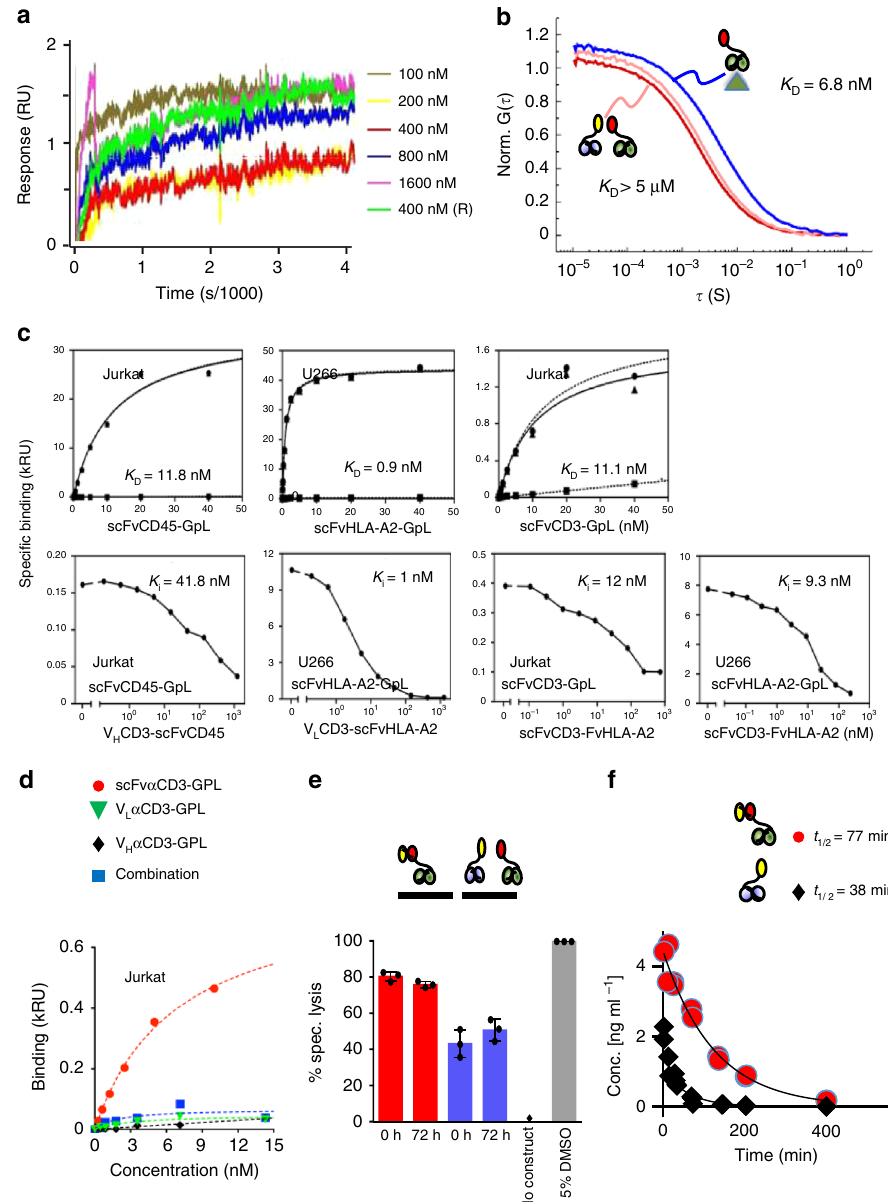
Fig. 3 Biochemical basis for hemibody complementation. a A plasmon resonance chip was coated with V L α CD3-scFv α HLA-A2. V H α CD3-scFv α CD45 was used as an analyte at 100, 200, 400, 800, 1600 (nM) as indicated. Association contact time was 300 s, dissociation contact time 3.600 s at a fl ow rate of 30 μ l/min, data represent one out of three experiments. b FCS autocorrelation functions, normalized to the number of molecules, recorded for 1 nM V L α CD3-scFv α HLA-A2 alone (dark red) and for the same sample in presence of 1 µ M V H α CD3-scFv α CD45 (light red) or 100 nM HLA-A2 antigen (blue). Curves are fi tted using data derived from three independent experiments c Top: Equilibrium binding study of scFv-GpL ( Gaussia princeps luciferase) fusion proteins speci fi c for CD45, HLA-A2, or CD3 to the respective antigens on 10 5 Jurkat (CD3 + , CD45 + ) and U266 cells (HLA-A2 + , CD45 + ). Speci fi c binding (triangles, solid line) was calculated as the difference of total (circles, dashed line) and non-speci fi c binding (squares, dashed line) determined by using an irrelevant scFv-GpL fusion protein, HLA-A2-negative KMS-12-BM cells or CD3-negative U266 cells as indicated. Bottom: For heterologous competition analysis, cells were incubated with scFvCD45-GpL (2 nM), scFvHLA-A2-GpL (2 nM), or scFvCD3-GpL (4 nM) and the indicated concentrations of the hemibodies or the bispeci fi c BiTE construct. IC 50 values were determined and used to calculate the K i of CD45-, HLA-A2-, and CD3-speci fi c scFv domains by help of the previously determined K D -values of the scFv-GpL fusion proteins. Data show one out of three experiments yielding comparable results. d scFvCD3 or isolated V H CD3 and V L CD3 domains were fused to GpL. No speci fi c binding of individual or combined constructs to CD3-positive Jurkat cells were detected as assessed by cell-bound luciferase activity. Data show one out of three experiments yielding comparable results. e Preservation of T cell triggering activity after incubation of hemibodies and BiTEs in human serum for 72 h at 37 °C. Read out was speci fi c lysis at E:T of 5:1. Data represent the mean (±SD) from three replicate wells from one out of three experiments yielding comparable results. f In vivo serum half-lives after intravenous injection of 8 µ g of a hemibody or BiTE construct into Balb/c mice. Values are deduced from >40 mice as determined by